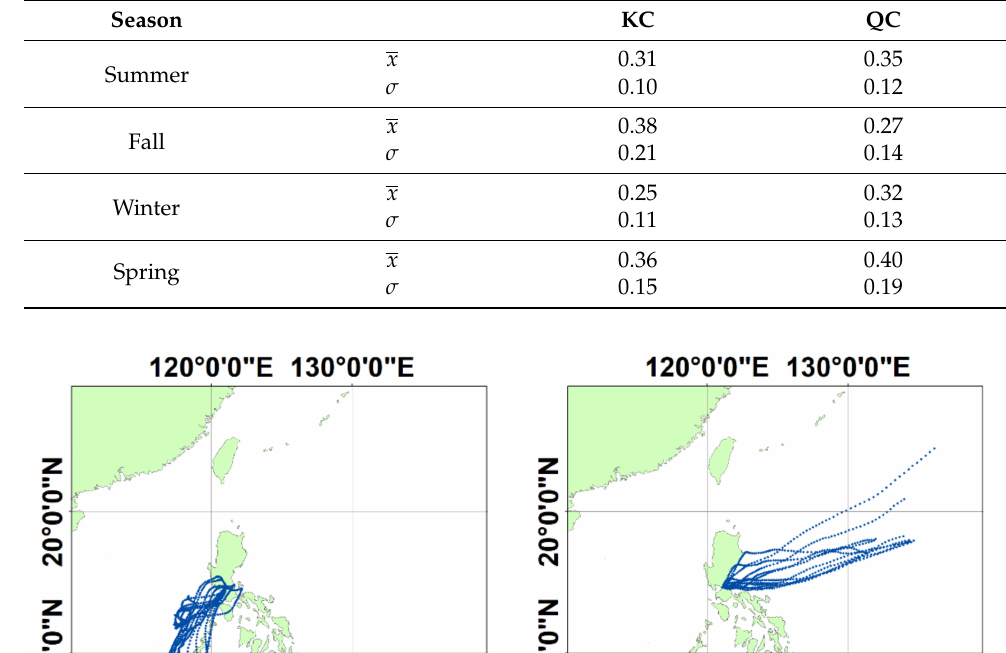
Table 3. Statistics of seasonal MODIS AOD values at the two study areas from 2010 to 2020.